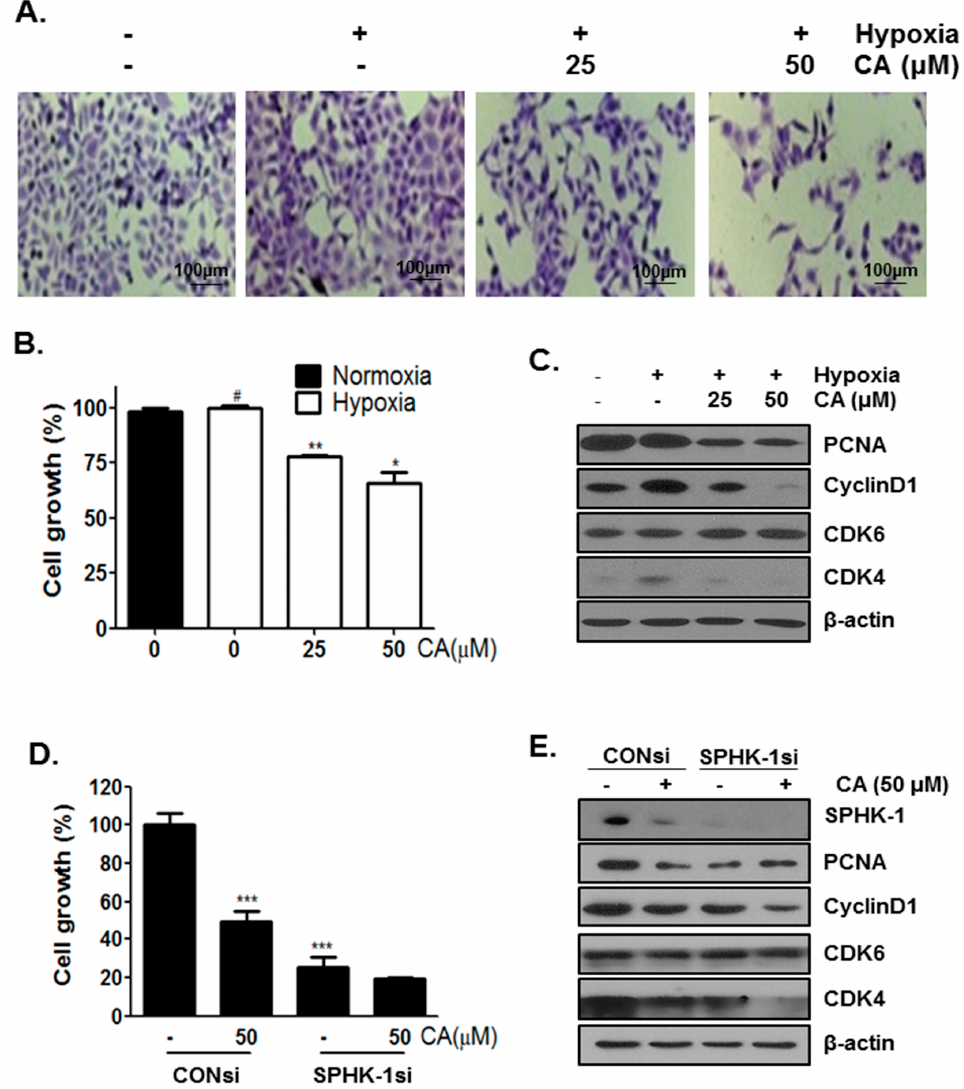
siRNA inhibited the expression of PCNA, cyclin D1, and CDK4 but did not affect the expression of CDK6.